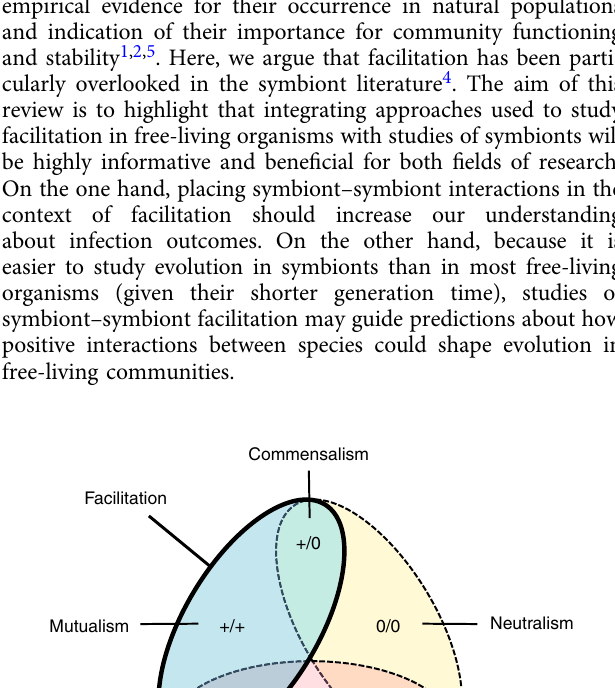
Fig. 1 Diagram showing the different types of ecological interactions. 0: no effect; – : negative effect; + : positive effect. Facilitation includes mutualistic, commensal and antagonistic